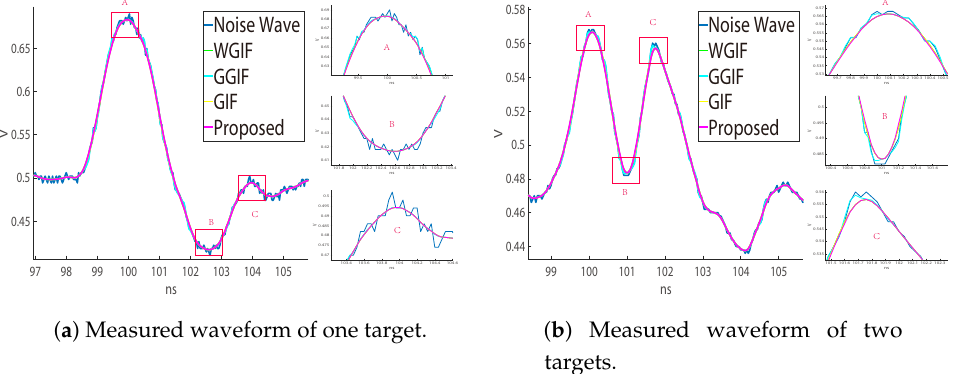
targets. Figure 6. Measured waveform noise suppression effect. ( a ) Comparison of noise suppression effect of one target. ( b ) Comparison of noise suppression effect of two targets.